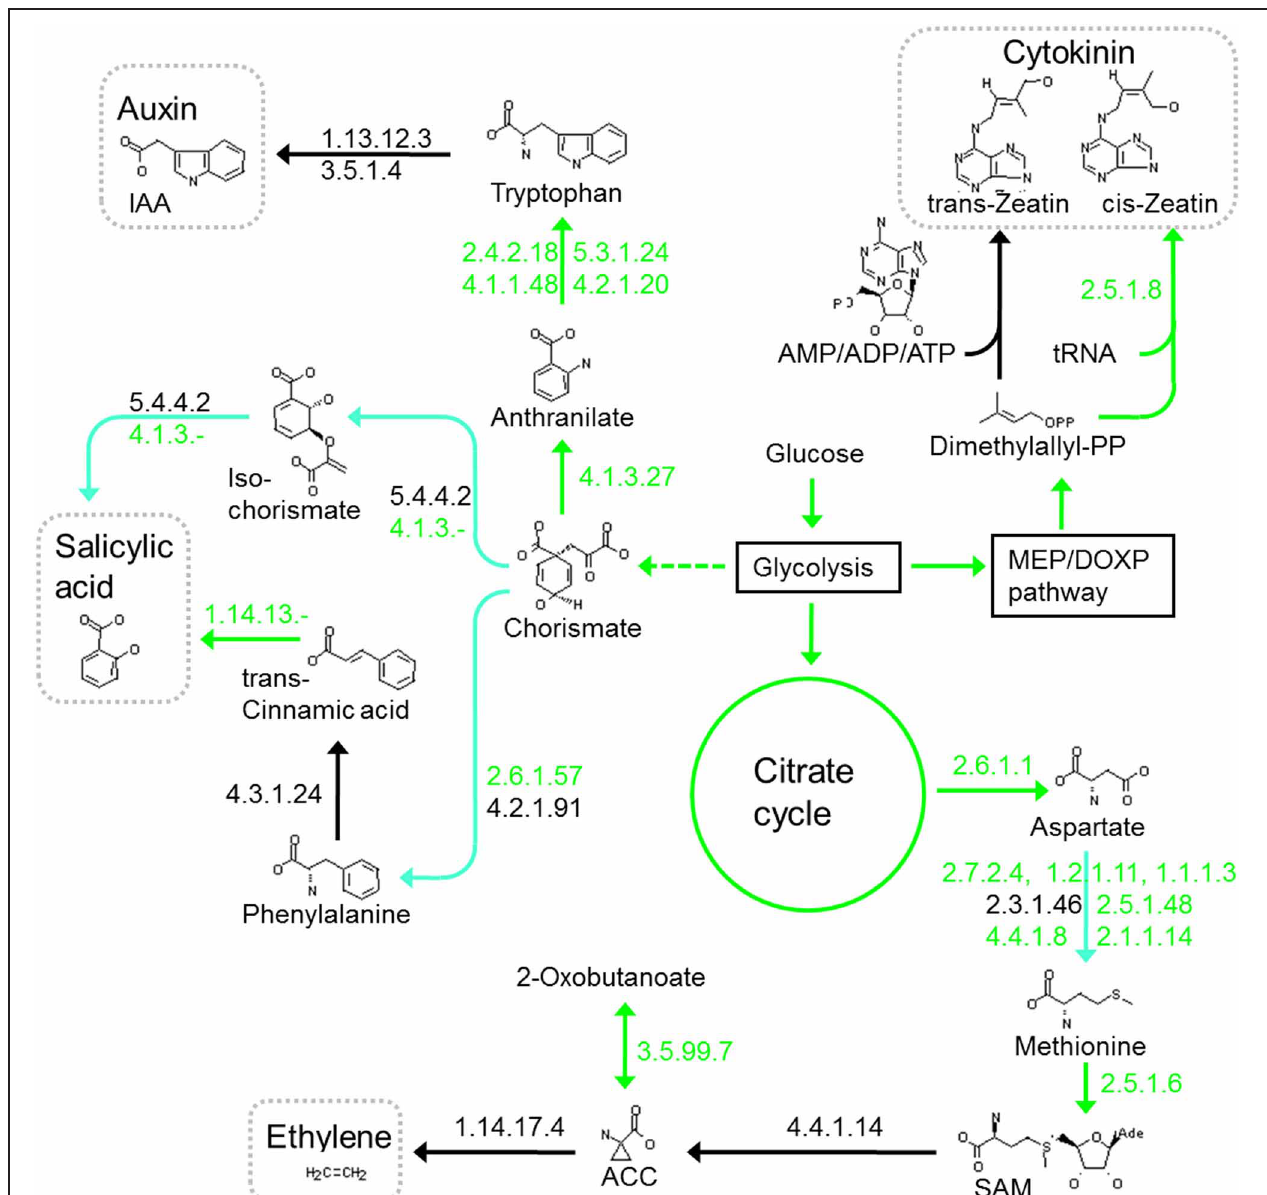
FIGURE 4 | Biosynthesis and manipulation of plant hormonesin HfGSF30 . Green arrows or EC numbers indicate possible reactions or present enzymes, turquoise arrows indicate that at least one enzyme is missing in the pathway, while black arrows or EC numbers indicate that this pathway or enzyme is